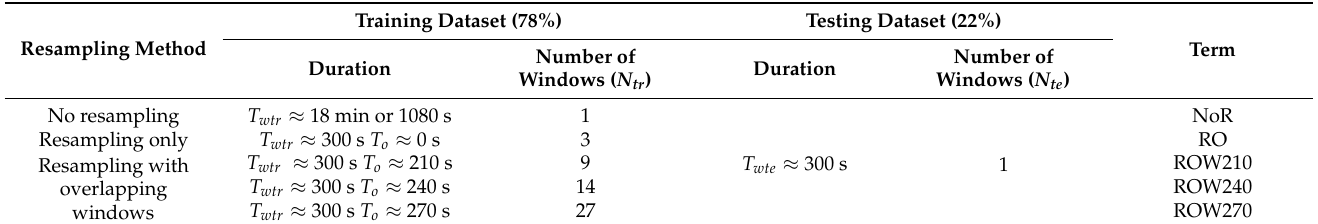
Table 3. List of resampling scenarios used in the proposed driving fatigue detection